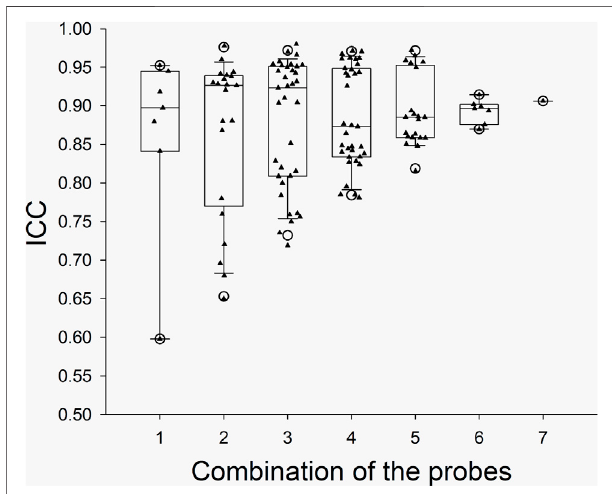
FIGURE 3 | Boxplots for the ICC between CVC values during the Leg Trials with the various probe combinations. X axis: the number of probes for the combinations. The calculated “ Minimum ” and “ Maximum ” values are indicated by open circles. The data below Minimum or above Maximum were outliers.